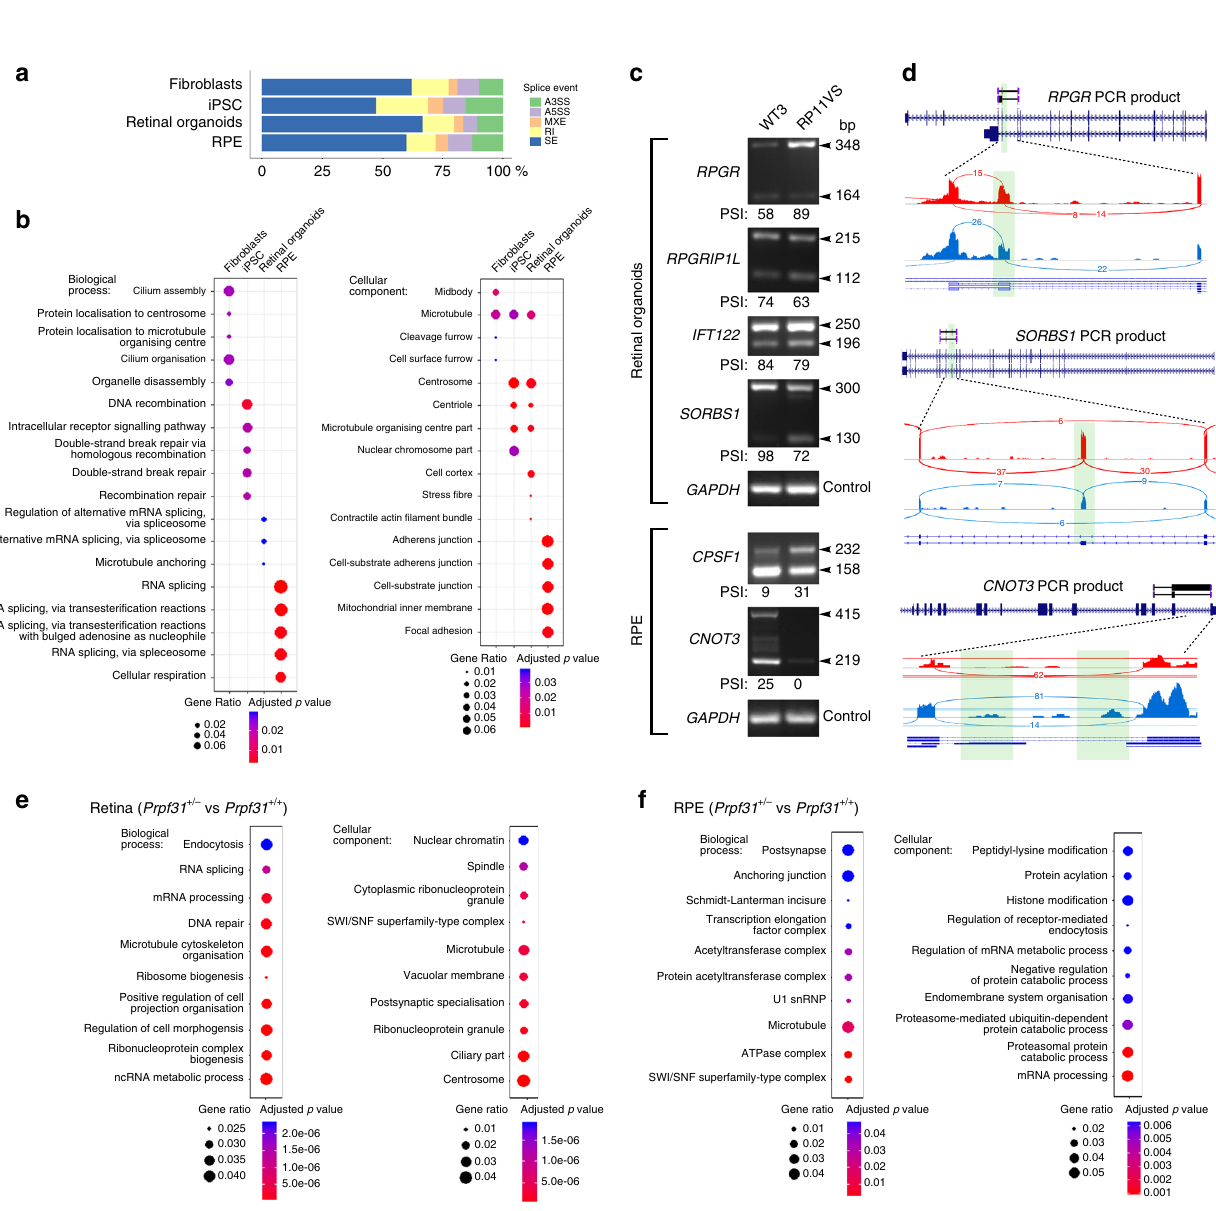
Fig. 3 PRPF31 expression in patient-speci fi c cells and effects on pre-mRNA splicing. a Gel electrophoresis showing the presence of a long mutant transcript (LM) isoform for the exon 11 deletion in patient-speci fi c cells. The short mutant (SM) isoform is present only upon inhibition of NMD with puromycin (indicated by + ); b The bar graph shows wild-type PRPF31 mRNA in patient cells relative to controls from a , b . Data are representative of at least three independent repeats, RO retinal organoids; c Wild-type PRPF31 is signi fi cantly reduced in patient RPE cells and less notably in retinal organoids. The LM form and reduced SART1 is observed only in the patient RPE cells; d The bar graph shows wild-type PRPF31 levels in patient cells relative to normal cells quanti fi ed from c , n = 3; e , f Patient RPE cells and retinal organoids exhibit a notable defect in the alternative splicing of E1A minigene reporter. Schematic representation of alternative splice variants of the E1A reporter ( e ) and denaturing PAGE and autoradiography using a phosphoimager ( f ), n = 3; g Northern blot analysis showing the level of snRNAs in various normal and patient cells. Total RNA was isolated from each sample and snRNA levels were analysed by denaturing PAGE followed by Northern blotting using probes against U1, U2, U4, U5, U6 and 5S rRNA (top). The levels of snRNAs were quanti fi ed and normalised to the amount of 5S rRNA (bottom), n = 2. All error bars represent